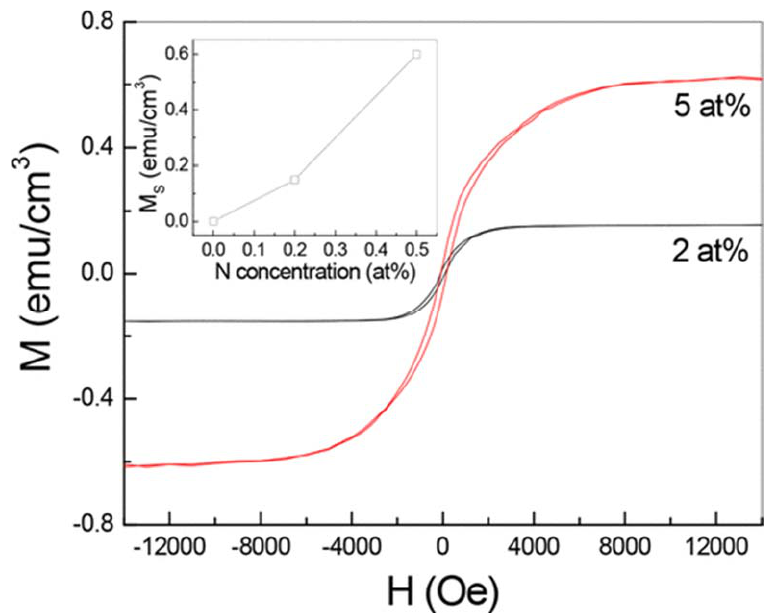
Figure 15. Magnetic hysteresis loops of N ‐ doped In 2 O 3 films with 2 and 5 at.% ratio of N recorded at 300 K (Reprinted with permission from American Chemical Society [113]).